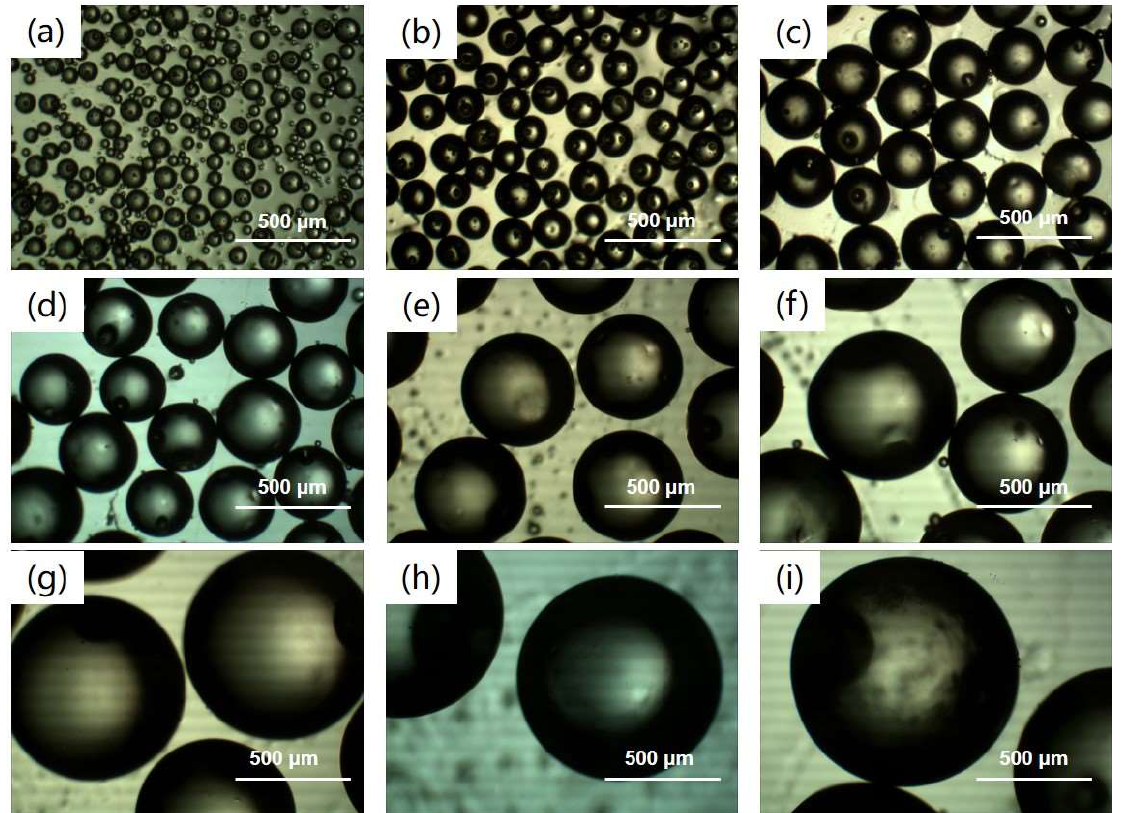
Figure 2. The optical micrographs of PLGA microspheres with different size fractions. ( a ) 0~200 µm;